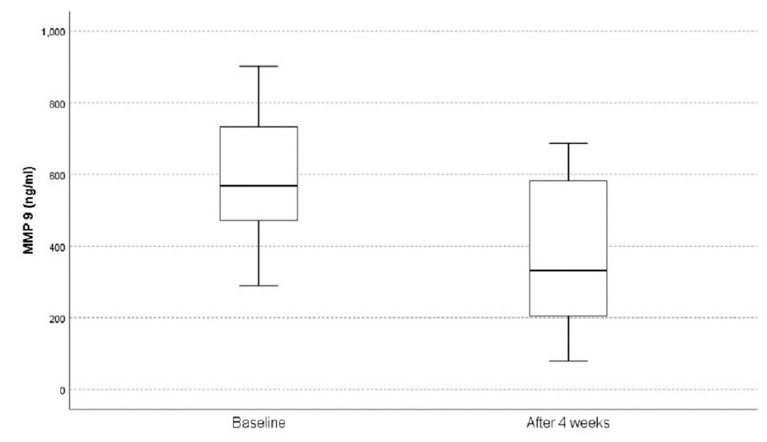
Figure 2. MMP-9 values in the follow-up period. Table 2. Biochemical parameters. Table 3. Association MMP-9 values after PBD procedure with clinical parameters (multivariate linear regression analysis).